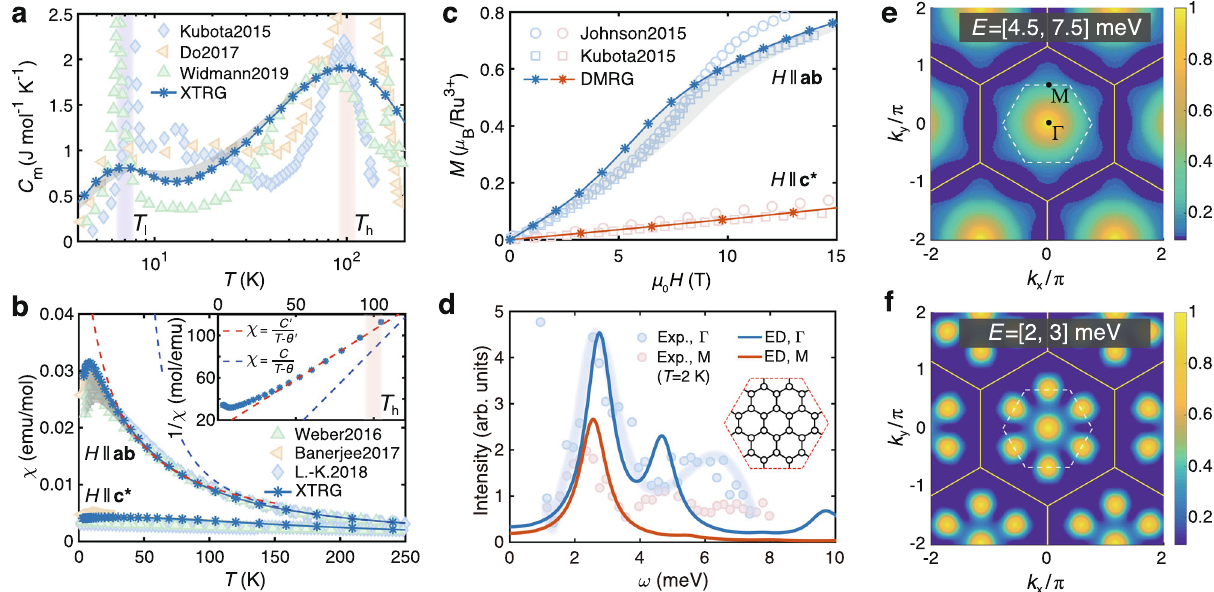
Fig. 2 Model simulations of thermodynamic and dynamic properties. With the K - J - Γ - Γ 0 model, we perform many-body simulations and compare the results to experiments, including ( a ) the magnetic speci fi c heat C m 3,15,52 , ( b ) in-plane ( χ ab ) and out-of-plane ( χ ) susceptibilities (measured at the fi eld of c (cid:4) 1 T) 14,53,54 , and ( c ) magnetization curves M ( H ) 3,55 on the YC4 × L × 2 lattice, with the gray shaded region indicating the in fl uences of different system lengths L = 4, 6. The Curie-Weiss fi ttings of the high- and intermediate- T susceptibility χ ab in ( b ) lead to C ≃ 0.67 cm 3 K/mol, θ ≃ 41.4 K, and C 0 ’ 1 : 07 cm 3 K/mol, θ 0 ’ (cid:5) 12 : 7 K, respectively. We also compute the dynamical spin structure by ED and compare the results with neutron scattering intensity I ð k ; ω Þ at k = Γ and M in ( d ), on a C 3 symmetric 24-site cluster shown in the inset (see more information and its comparison to another 24-site cluster with lower symmetry in the Supplementary Fig. 4). The light blue bold line is a guide to the eye for INS data at Γ point 18 . The calculated intensity peak positions ω Γ and ω M are in very good agreement with experiments. We further plot the integrated intensities within the energy interval ( e ) [4.5, 7.5] meV and ( f ) [2, 3] meV, where a clear M-star shape is reproduced in ( e ) at intermediate energy and the bright M points are evident in ( f ) at low energy, both in excellent agreement with the INS experiments 14 . The dashed white hexagon marks the fi rst BZ, and the outer yellow hexagon is the extended intermediate- T Curie-Weiss scaling below T h 59 , as shown in ). Fig. 2b for χ ab (the same for χ c (cid:4) At the temperature T l ≃ 7 K, the experimental C m curves of α -